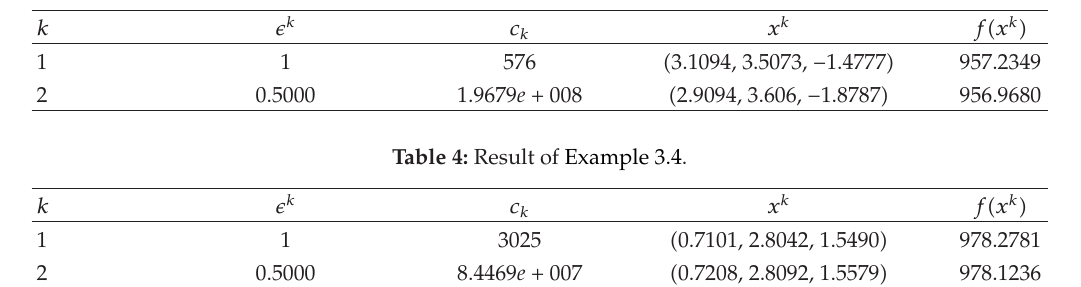
Table 3: Result of Example 3.3.